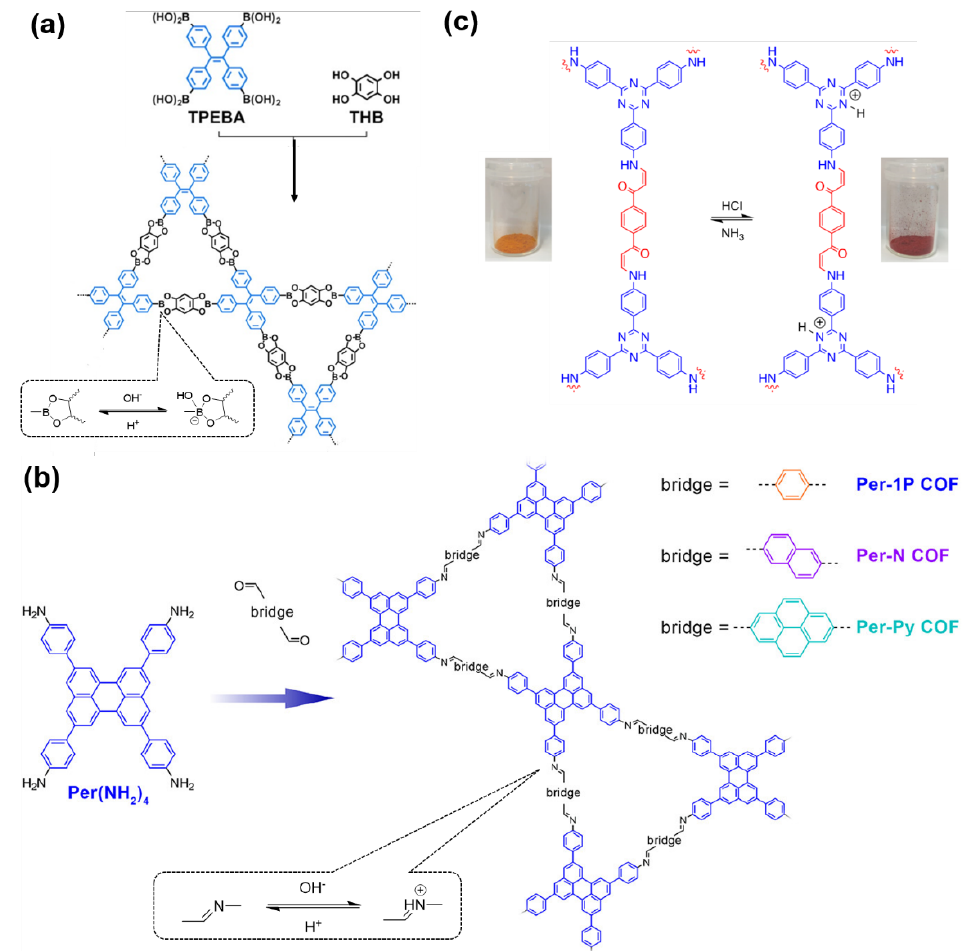
Figure 4. ( a ) COF for NH 3 sensing based on the protonation and deprotonation of boronate linkage [60]. Copyright 2016 American Chemical Society; ( b ) COF for HCl sensing is based on the protonation and deprotonation of imine linkage [47]. Copyright 2019 American Chemical Society; ( c ) COF for HCl, NH 3 sensing based on the protonation and deprotonation of imine linkage [57]. Copyright 2019 Nature Publishing Group.